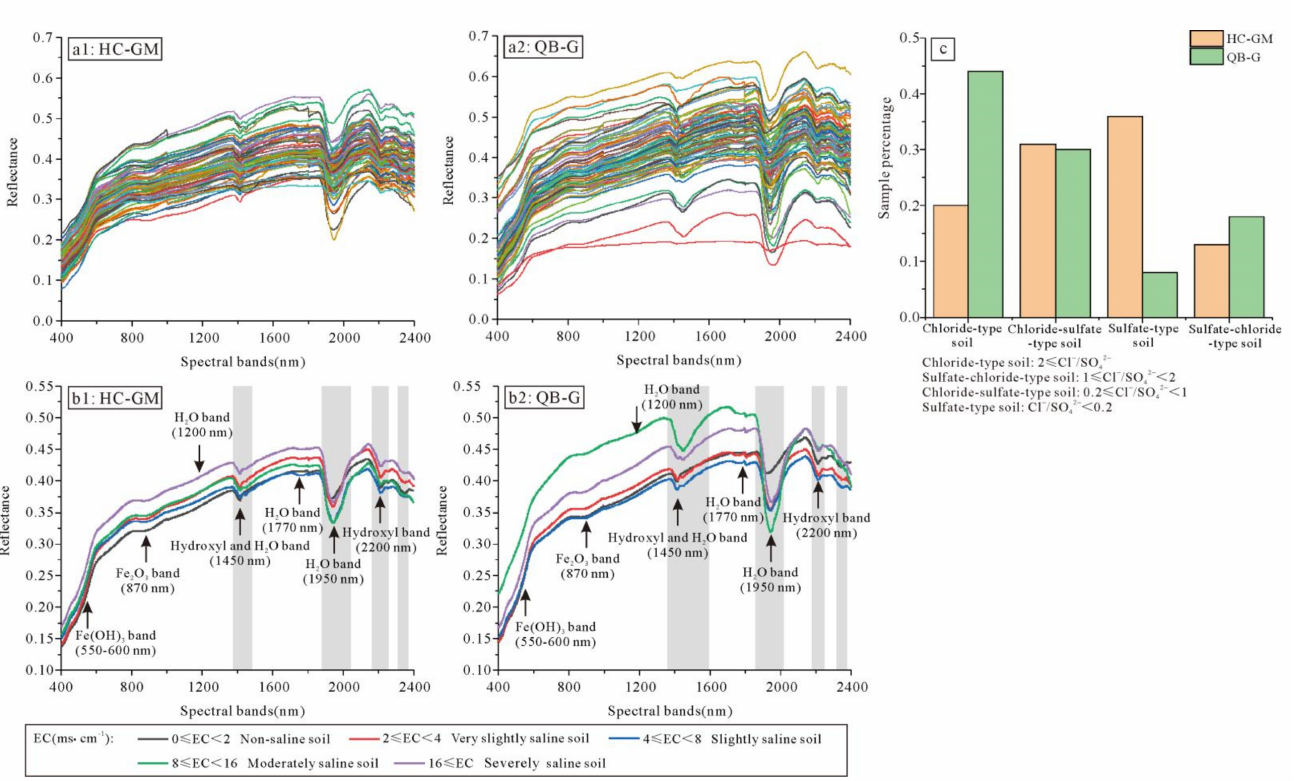
Figure 4. Hyperspectral reflectance curves of all of the soil samples ( a1 , a2 ), curve corresponding to different EC ( b1 , b2 ) and the chemical types of the soil samples measured in the laboratory ( c